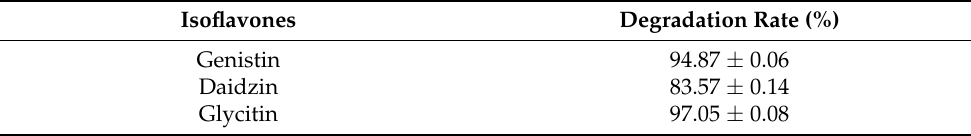
Figure 4. Analysis of isoflavones and related isoflavone aglycones changes in the fermentation of soymilk by L. paracasei TK1501 using HPLC. Standard molecules of isoflavones, including ( A ) genistin, ( B ) daidzin, and ( C ) glycitin; and their corresponding aglycones of ( D ) genistein, ( E ) daidzein, and ( F ) glycitein. Fermented soymilk ( G ) without and ( H ) with L. paracasei TK1501; in which compounds 1–6 were genistin, daidzin, and glycitin; and genistein, daidzein, and glycitein, respectively. Table 4. The degradation rate of isoflavones in the L. paracasei TK1501 fermented